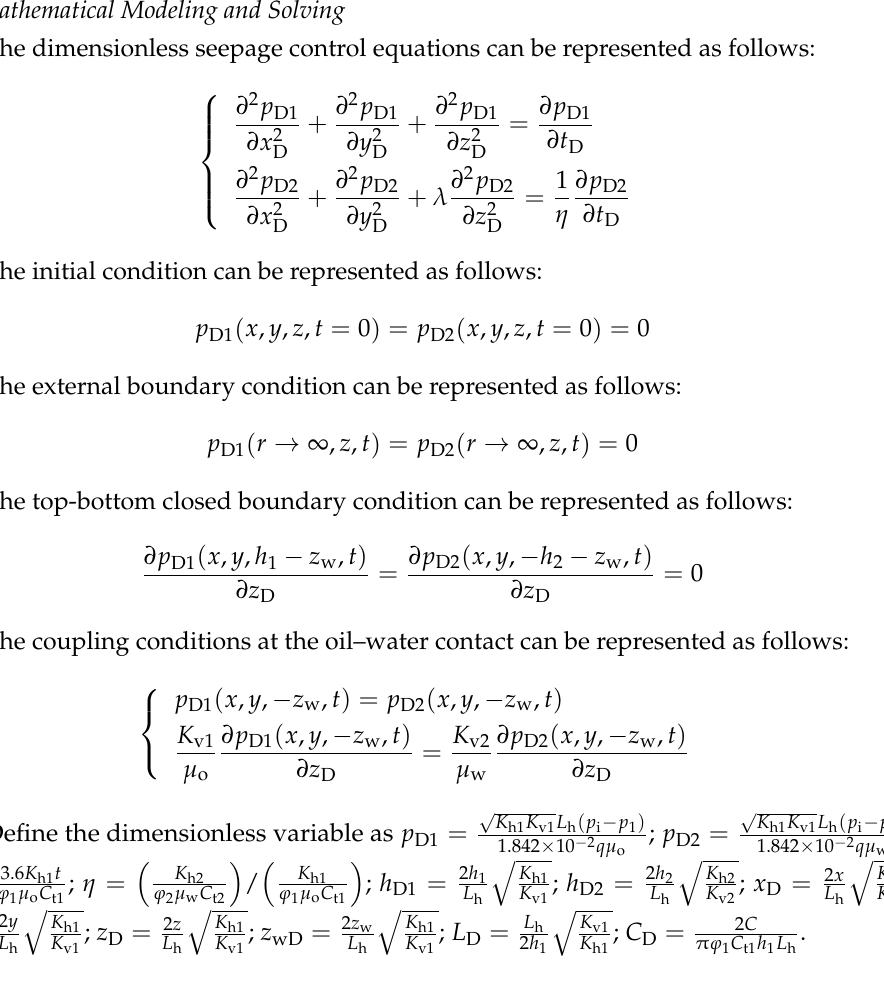
Figure 1. Physical model of a horizontal well in a bottom-water reservoir with finite water bodies.